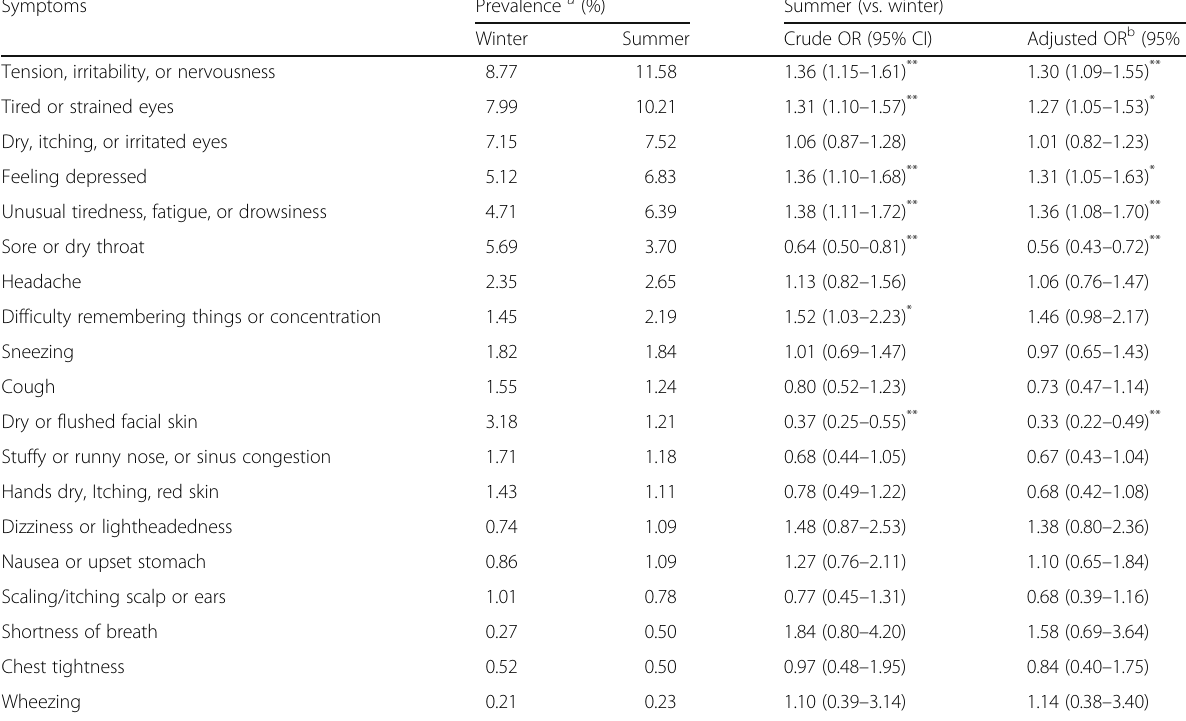
eyes, ” and “ dry, itching, or irritated eyes ” during summer (19%), and “ pain or stiffness in the back, shoulders, or neck ” were 11.6%, 10.2%, and 7.5%, respectively. The lowest (17%). The lowest prevalence was associated with “ short- prevalence was “ wheezing ” (0.2%) in both seasons. In both ness of breath and wheezing ” (2%). In our study, the three BASE and our studies, the prevalence of BRSs followed most prevalent BRSs during winter were “ tension, irritabil- approximately the same rank ordering. Compared with the ity, or nervousness ” (8.8%), “ tired or strained eyes ” (8.0%), BASE study, overall prevalence was lower in our studies. and “ dry, itching, or irritated eyes ” (7.1%). The prevalence However, the prevalence of “ feeling depressed ” in both of “ tension, irritability, or nervousness, ” “ tired or strained Table 7 Comparison of prevalence of weekly building-related symptoms between winter and summer Symptoms Prevalence a (%) Summer (vs.